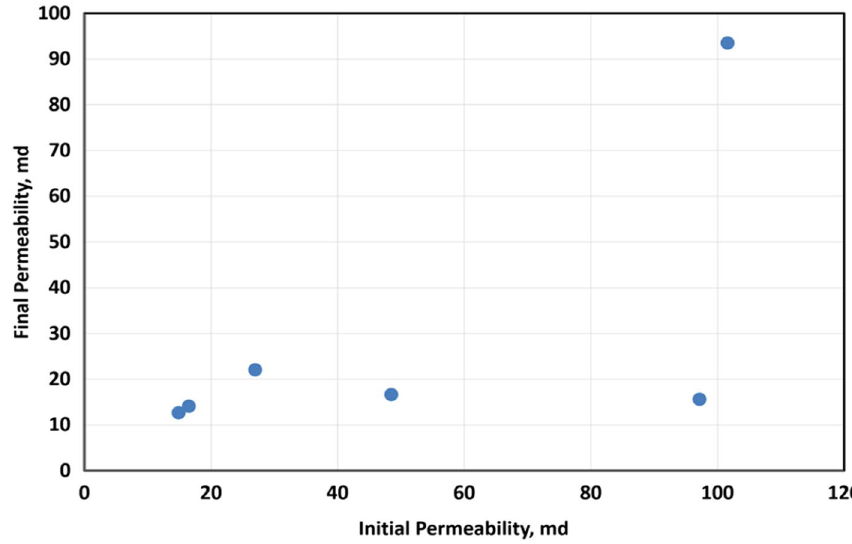
Fig. 12 Cross plot of initial versus final permeability